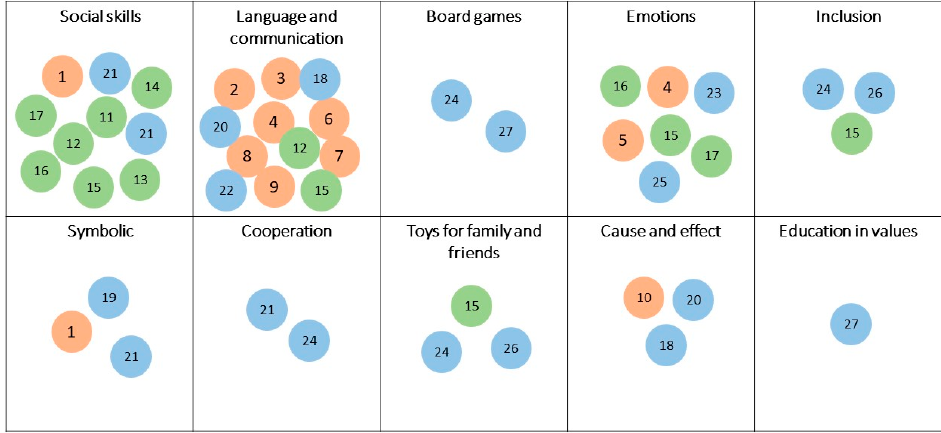
Figure 10. Analysis of the sample based on the categories of toys intended for collaboration.